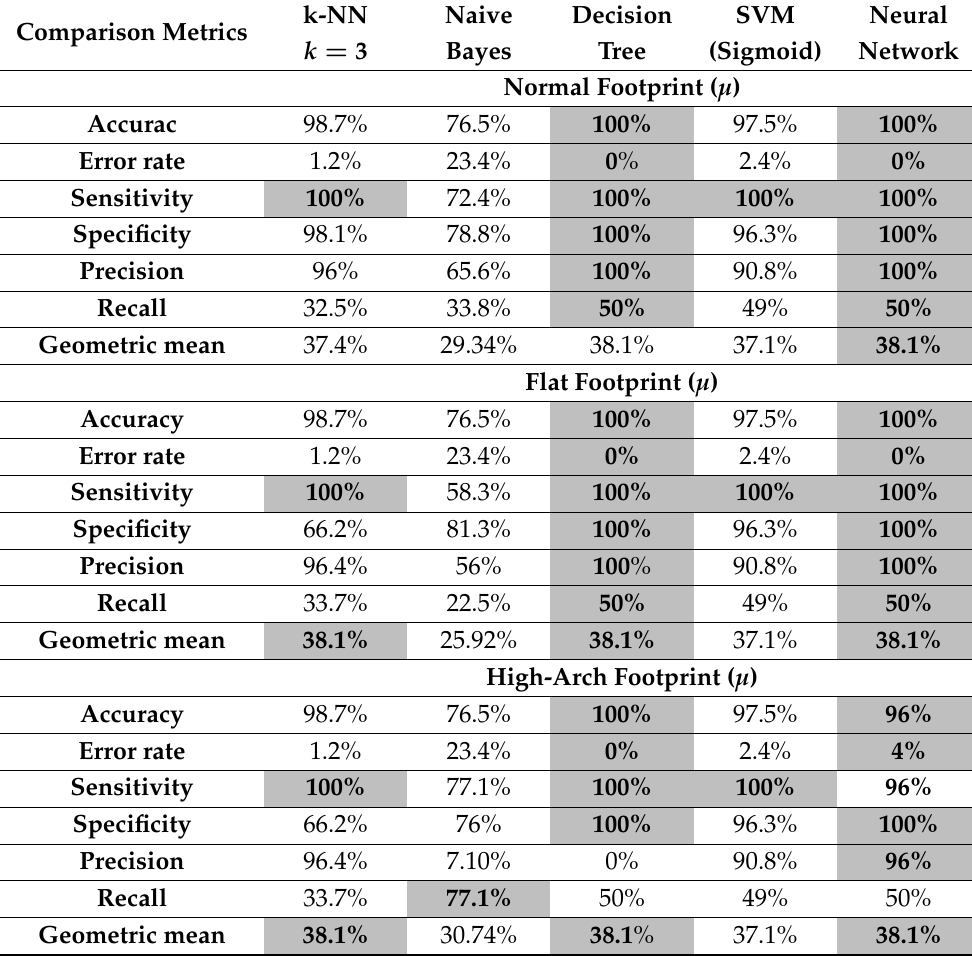
Table 4. Matrix Y classification metrics’ comparison under Stage II.